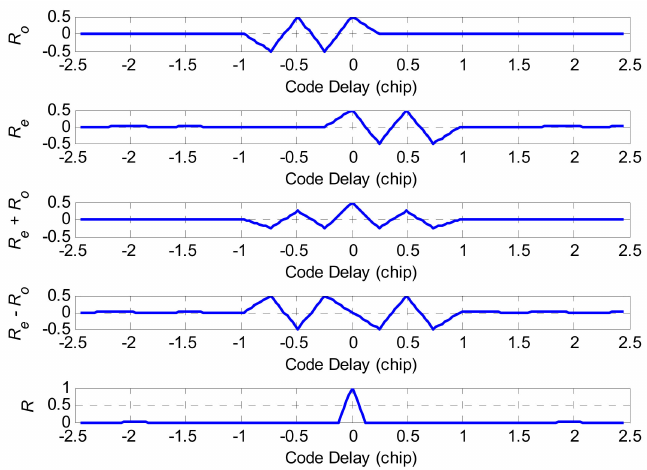
Figure 9. The reconstruction correlation function of the BOCs(2,1)